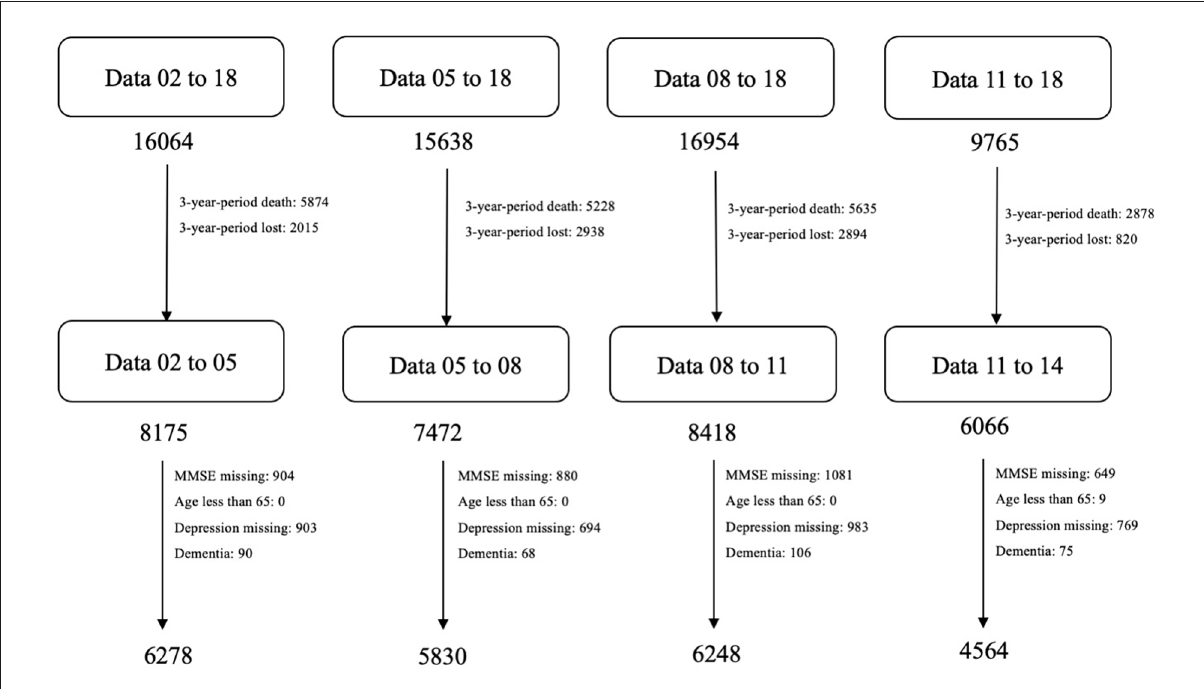
FIGURE1 The inclusion and exclusion criteria of this study.